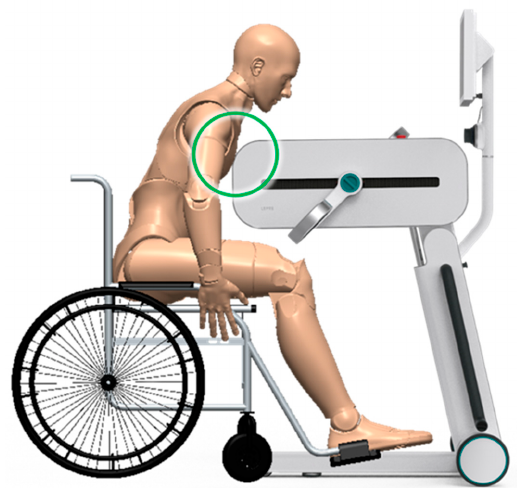
Figure 9. Illustrative detail of the contact between the patient’s trunk and the carter in correspondence with the radius of curvature.